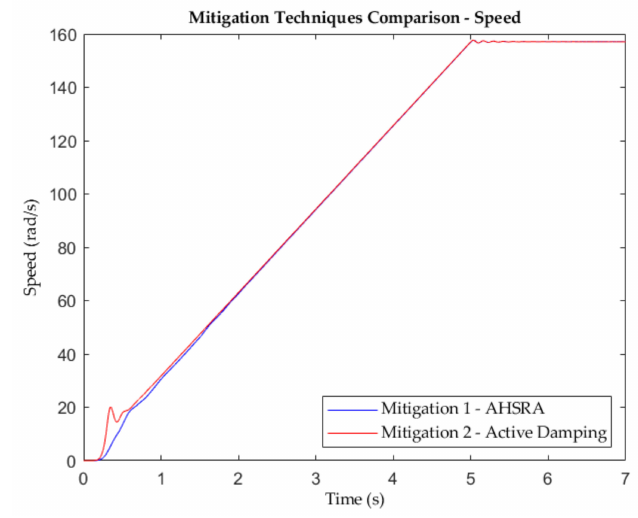
Figure 18. Mechanical speed—AHSRA (blue) vs. active damping technique (red).